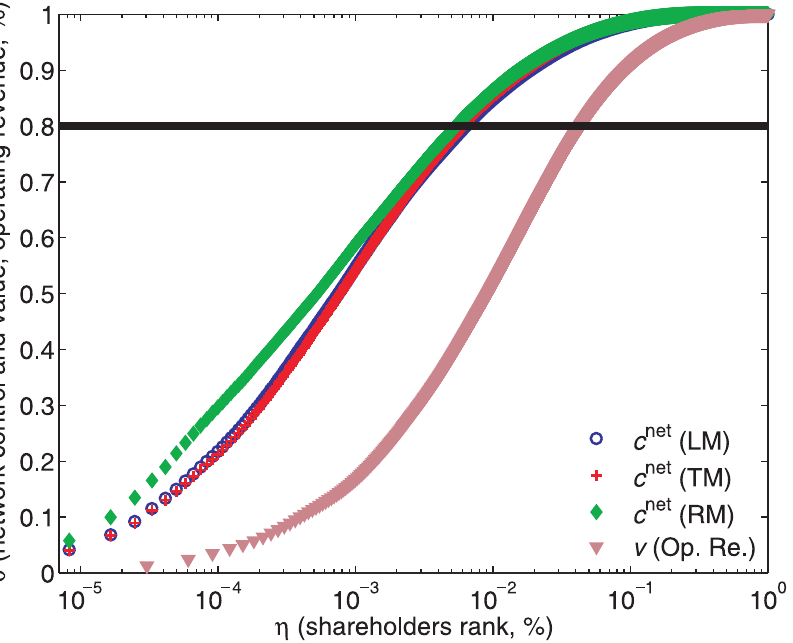
Figure 3. Concentration of network control and operating revenue. Economic actors (TNCs and shareholders) are sorted by descending importance, as given by c net . A data point located at ( g , h ) corresponds to a fraction g of top economic actors cumulatively holding the fraction h of network control, value or operating revenue. The different curves refer to network control computed with three models (LM, TM, RM), see Appendix S1, Section 3.1, and operating revenue. The horizontal line denotes a value of h equal to 80% . The level of concentration is determined by the g value of the intersection between each curve and the horizontal line. The scale is semi-log.